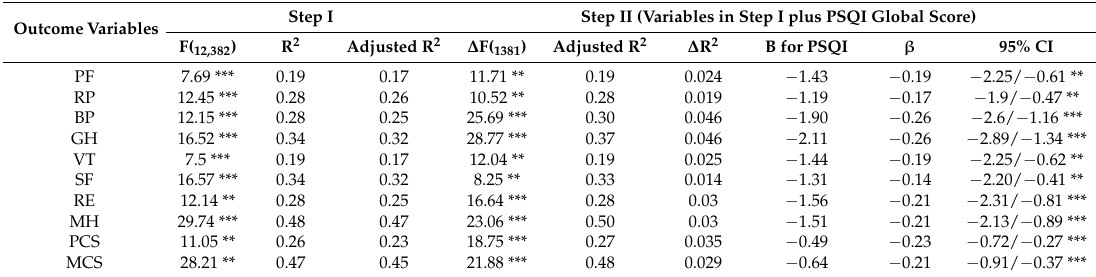
Table 4. Hierarchical multiple regression analyses of the associations between sleep quality and HRQoL